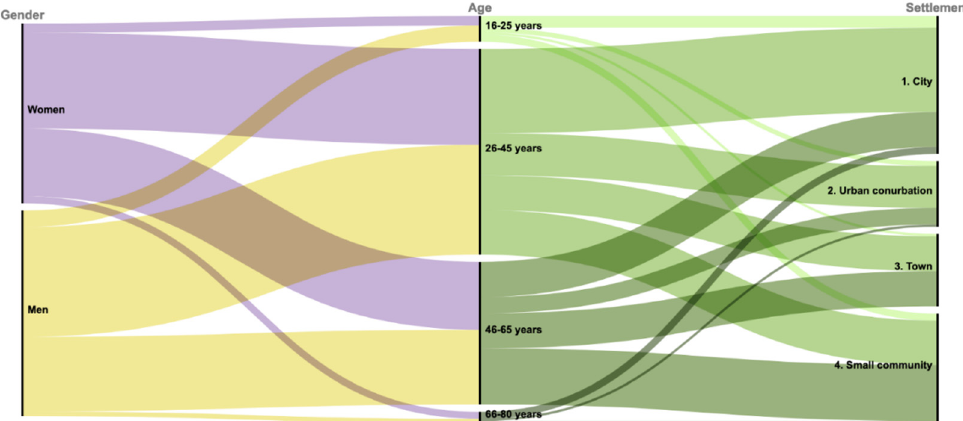
Figure 2. Representation, through an alluvial diagram, of the correlation between gender, age and place of residence of the participating activists. Each rectangle represents a unique value in the selected dimension, and its height is proportional to its value. Figure produced with RawGraphs.